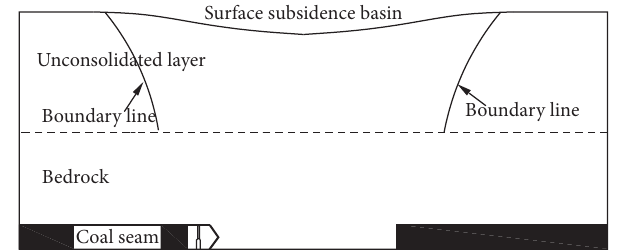
Figure 7: Movement boundary shape of the loose layer.